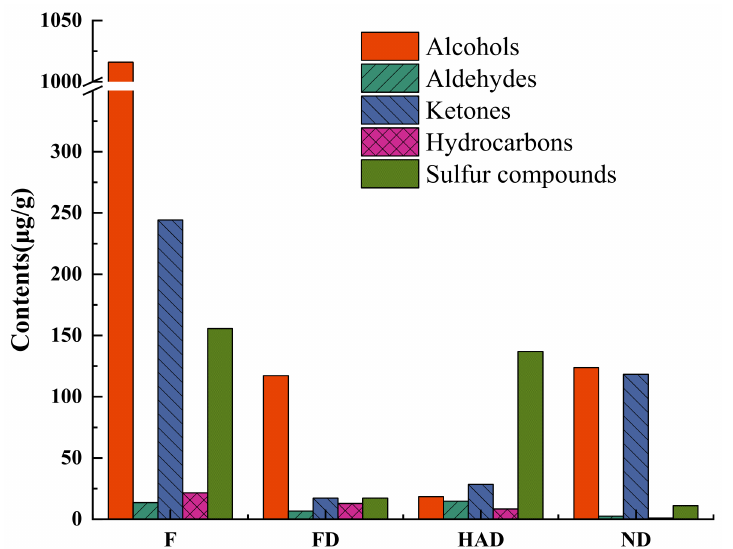
Figure 2. Contents of different types of volatile compounds in fresh and different dried L. edodes ; F: fresh sample; FD: freeze drying sample; HAD: hot-air drying sample; ND: natural drying